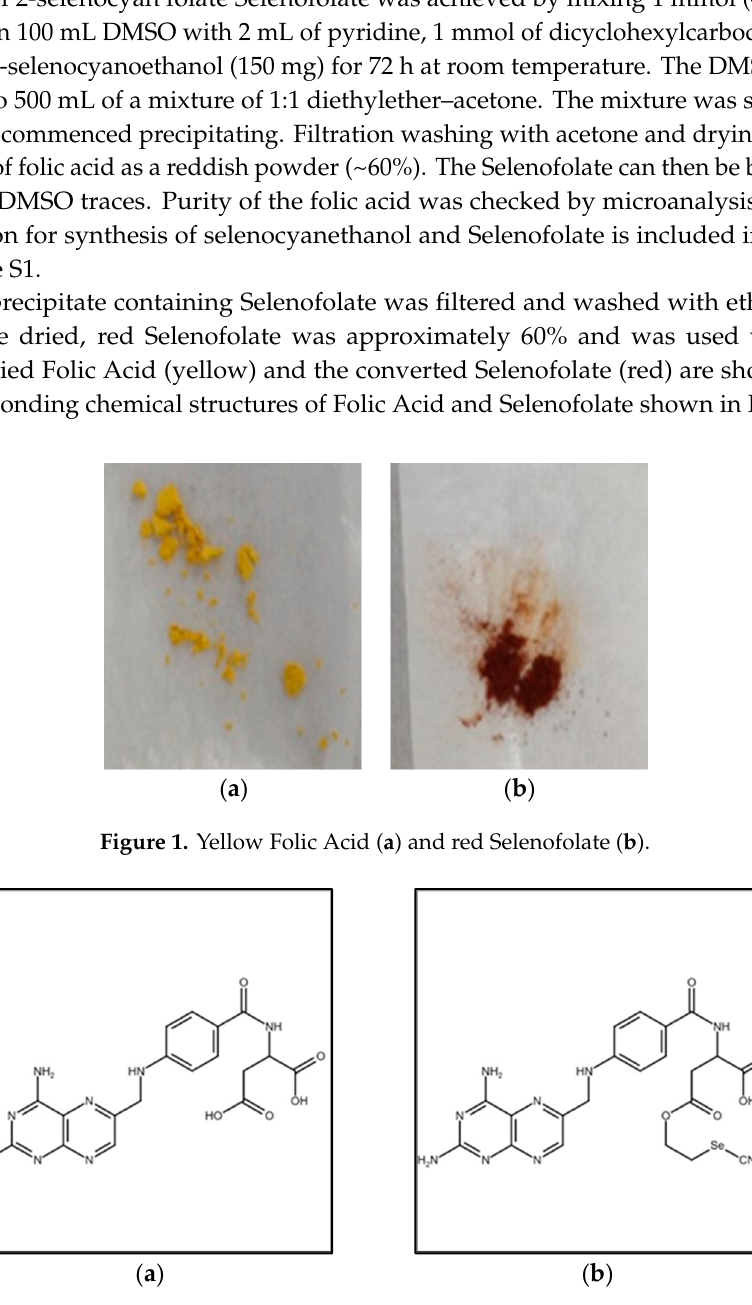
Figure 2. Structure of Folic Acid ( a ) and Selenofolate ( b ).